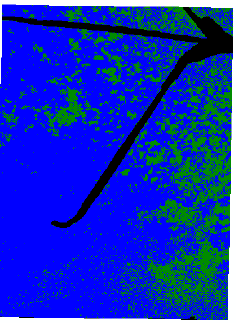
Figure 3: Classified Stitched Image